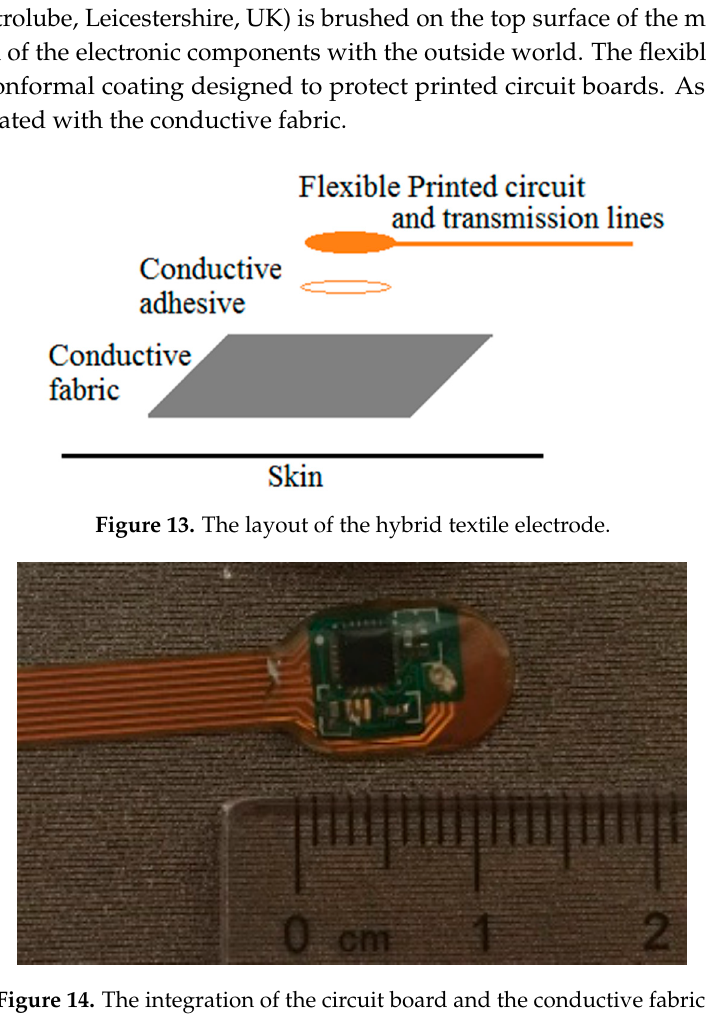
Figure 14. The integration of the circuit board and the conductive fabric.